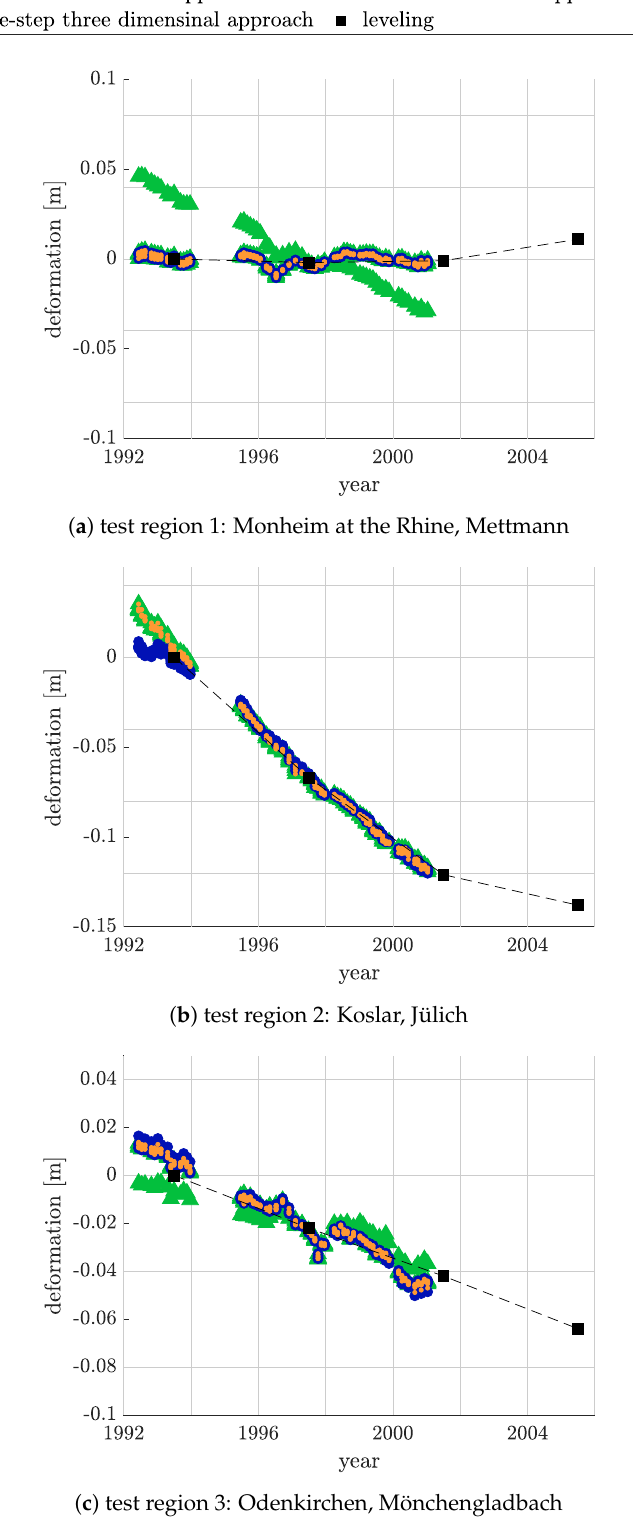
Figure 8. Deformation time series of five pixels lying in each of the three highlighted test regions shown in Figure 6. ( a ) shows the pixels in Mohnheim at the Rhine, ( b ) in Koslar and ( c ) in Odenkirchen. The results using the conventional EMCF approach are shown as green triangles, using the alternative EMCF as dark blue points and using the one-step three-dimensional approach as orange points. The black squares indicate the data from the closest leveling